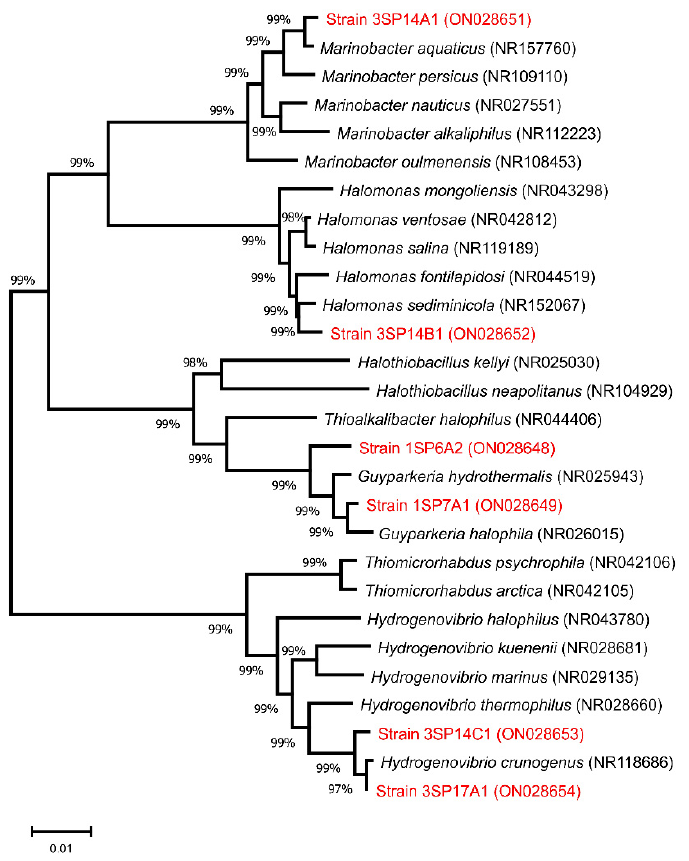
Figure 1. Unrooted neighbor-joining phylogenetic tree showing the relationship of 16S rRNA gene sequences of bacteria isolated in this study (red) with genes of their closest relatives. The scale represents evolutionary distances, which are in the units of the number of base substitutions per site.